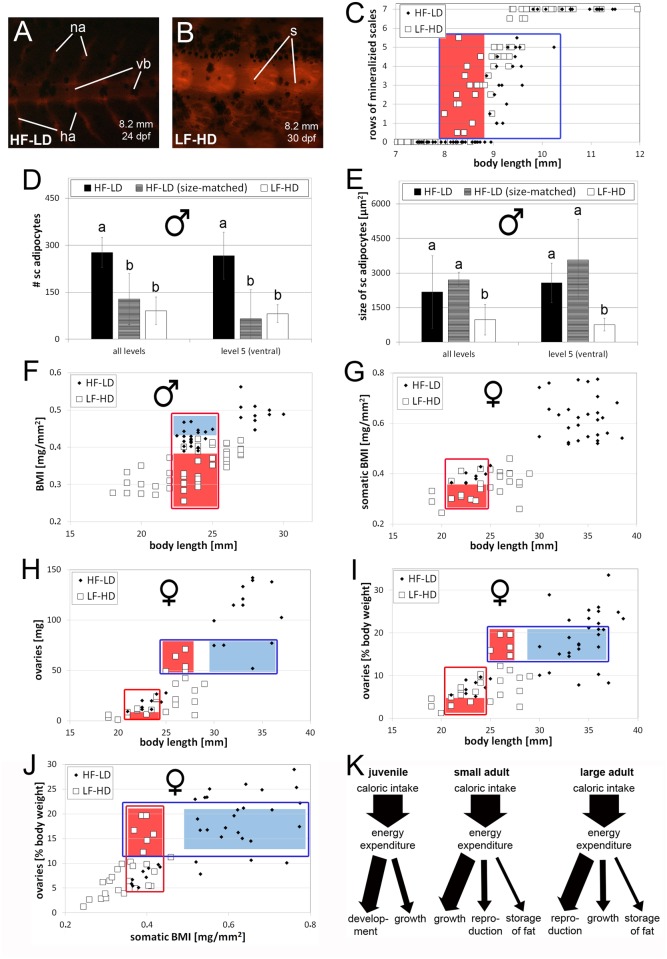
Caloric intake has differential effects on the timing of scale formation, somatic and ovarian growth and fat incorporation.A-B: Alizarin red staining of size-matched juvenile HF-LD (A) and LF-HD (B); body lengths and ages of the shown individuals are indicated. The flank of the LF-HD fish has several rows of mineralized scales, whereas no scales are visible in the corresponding region of the HF-LD fish. (C) Plot of rows of mineralized scales vs body length. (D,E) Comparison of numbers (D) and sizes (E) of subcutaneous adipocyte sizes (E) of 18 months old LF-HD males (white columns) with age-matched HF-LD male siblings (black column) and size-matched HF-LD males (striped columns; age: 2 months). Standard lengths of investigated fish were: HD-LD, 18 months: 32.3 +/- 1.0 mm; HF-LD, 2 months: 23.0 +/- 0,8 mm; LF-HD, 18 months; 22.5 +/- 1.0 mm. Left sides of each panel show average numbers from 5 corresponding longitudinal levels along the entire dorsoventral axis (for averages of single levels, see S7 Fig.), right sides show numbers for level 5 only (ventral). Columns with different superscript letter are significantly different (p<0.05) according to ANOVA followed by the Least Significant Difference (Bonferroni’s) test; n = 40 (2 fish per condition, 5 levels per fish, 2 sections per level and left and right side per section). F-J: Plots of BMI vs length of males (F); somatic BMI vs. length of females (G); absolute ovary weight vs. length (including 2 months HF females) (H); relative ovary weight vs. length (I); relative ovarian weight vs. somatic BMI (J). Crucial parameter intervals in (C, F-J) are boxed in red or blue, intervals only occupied by HF-LD fish are highlighted in blue, intervals only occupied by LF-HD fish in red. In (G-J), HF-LD females in regions boxed in red were 2 months of age, but already sexually mature. K: Schemes showing differential energy allocations to scale formation / postembryonic development, growth, reproduction and fat storage in juvenile, small and large adult fish. Abbreviations: ha, hemal arch; na, neural arch; s, scale; vb, vertebral body.